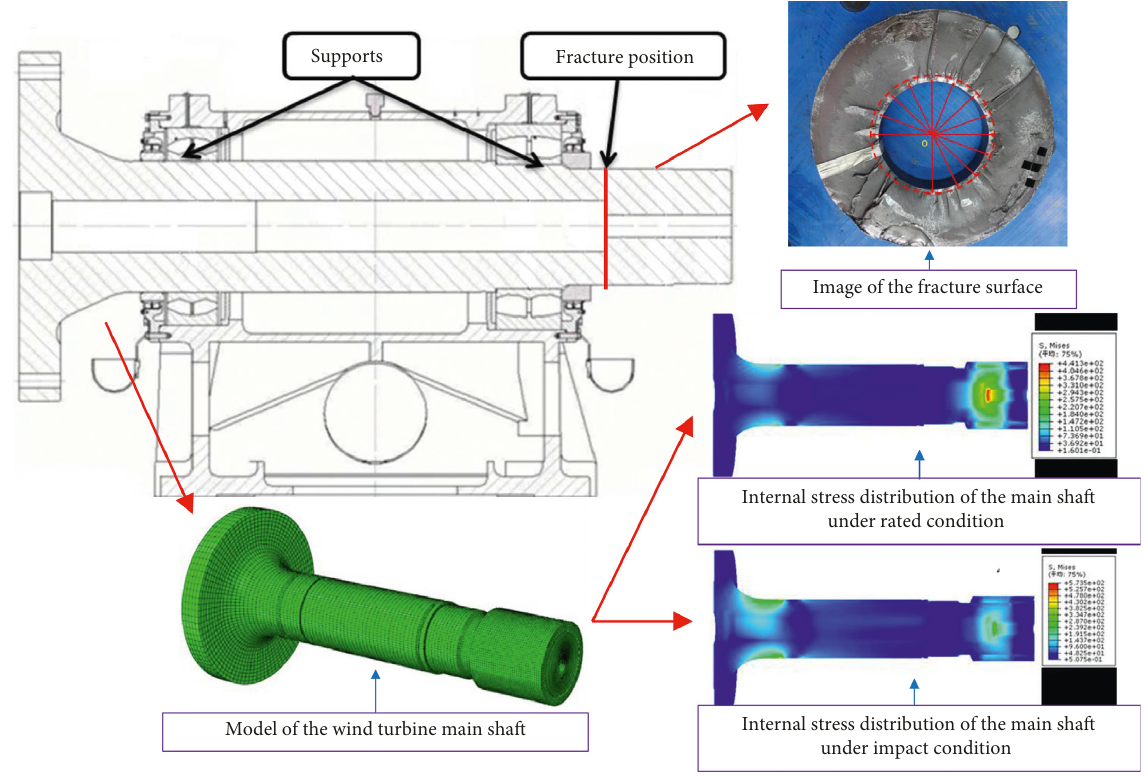
Figure 2: Numerical simulations of the wind turbine main shaft.